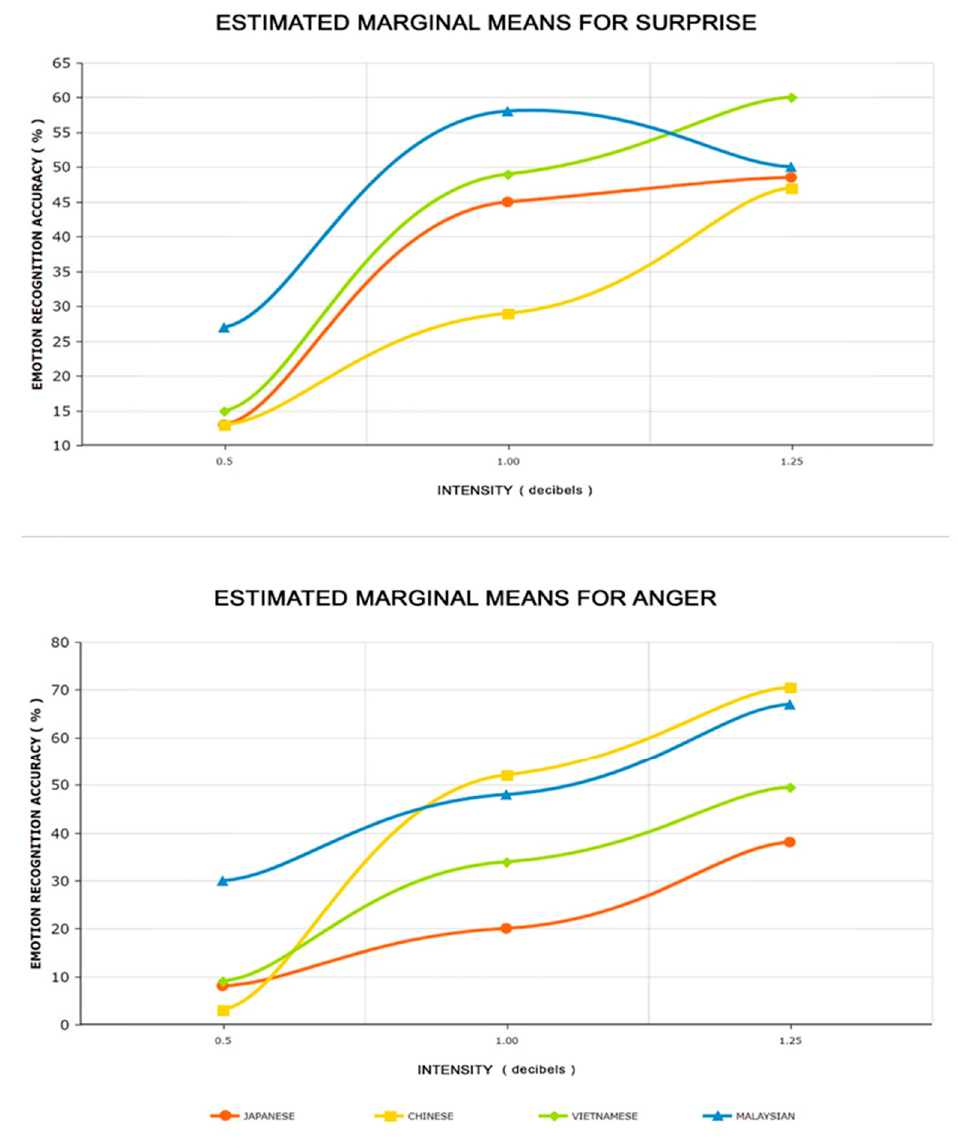
Figure 5. Graph showing the two-way MANOVA analysis between Intensity and Ethnicity for Anger and Surprise emotions.